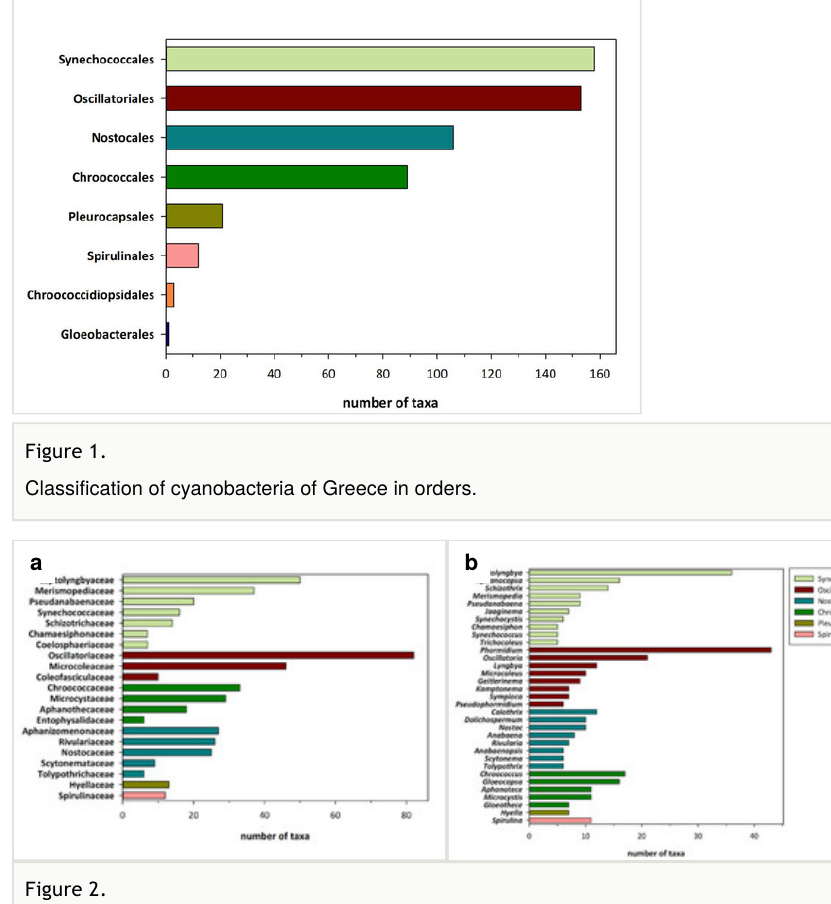
Figure 2. Classi fi cation of cyanobacteria of Greece in families (a) and genera (b). Only families and genera including more than fi ve species are